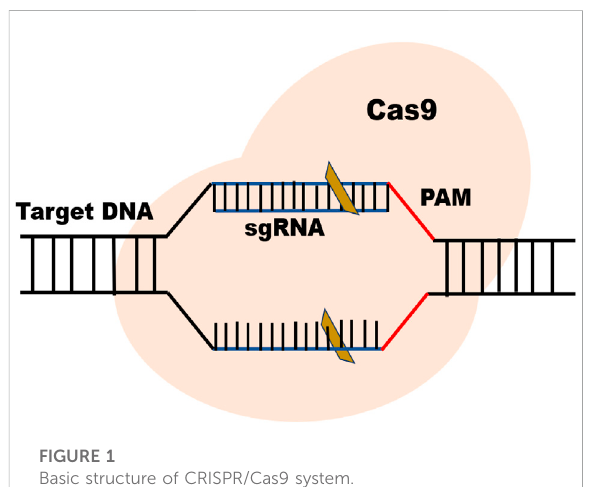
FIGURE 1 Basic structure of CRISPR/Cas9 system.